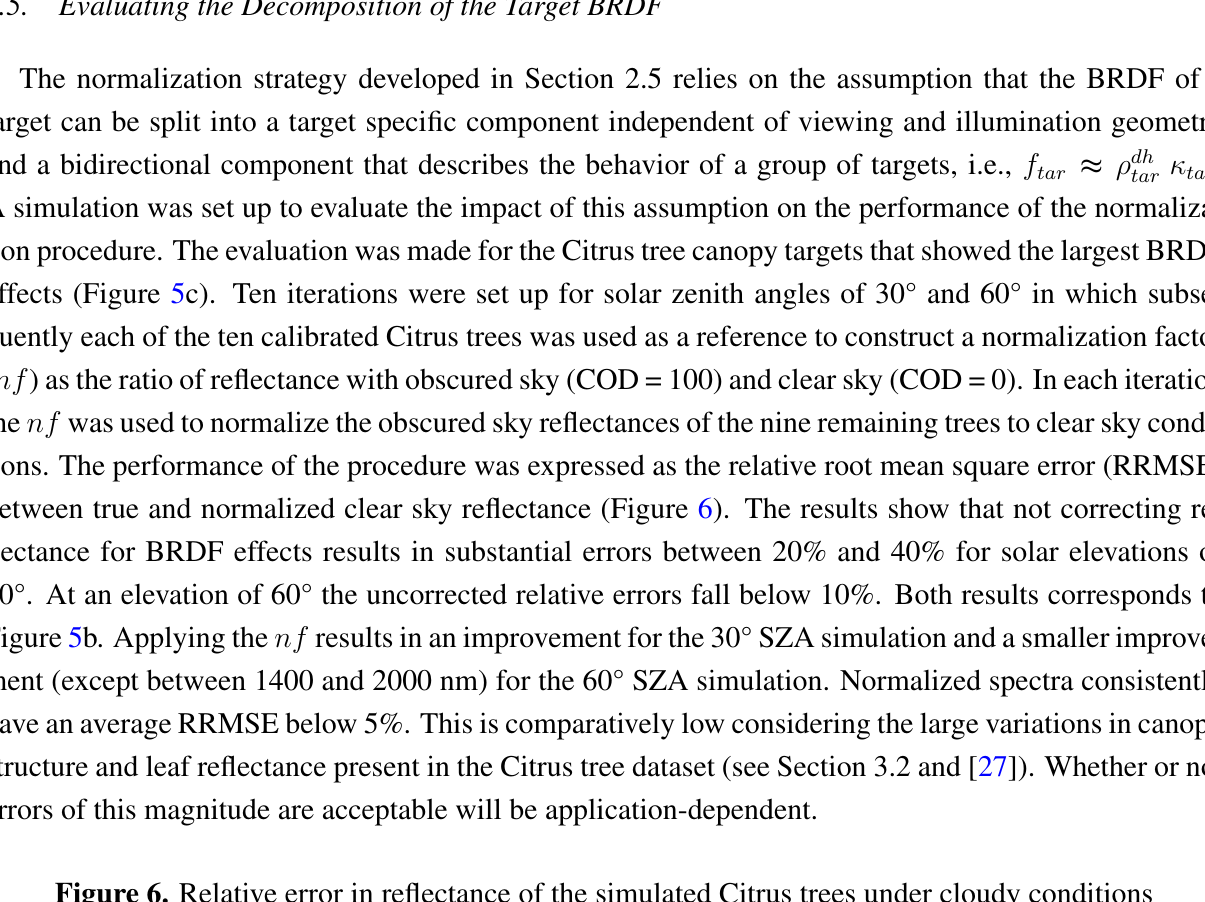
Figure 6. Relative error in reflectance of the simulated Citrus trees under cloudy conditions (COD = 100) using a clear sky reflectance (COD = 0) as a reference, simulated with pbrt and SBDart. Averages for 10 Citrus tree canopy targets and two solar zenith angles. Black curves: uncorrected reflectance, grey curves: corrected